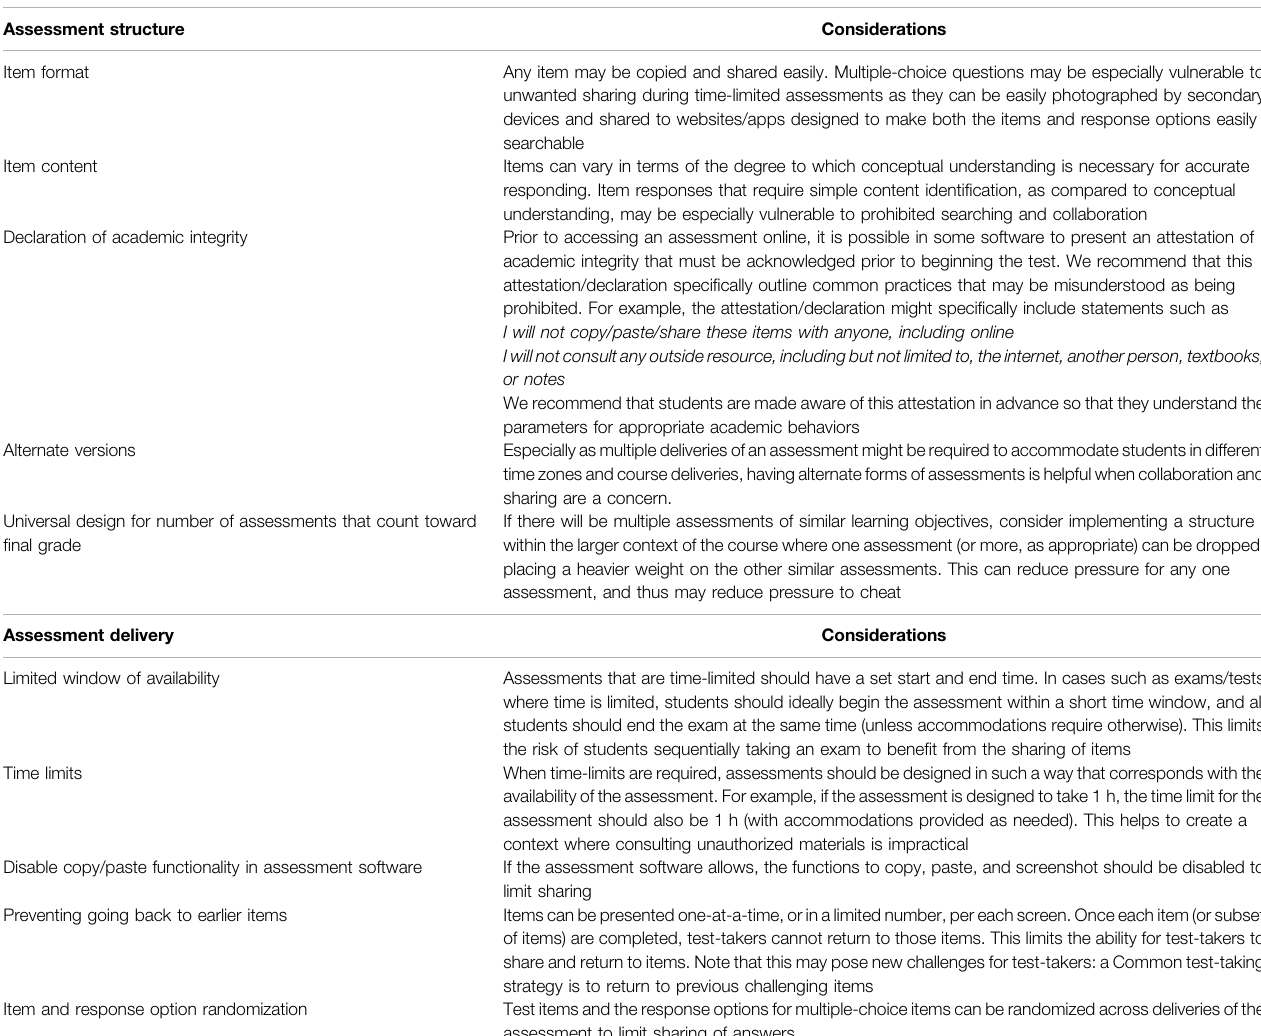
TABLE 2 | Preventing cheating and facilitating academic integrity through assessment structure and